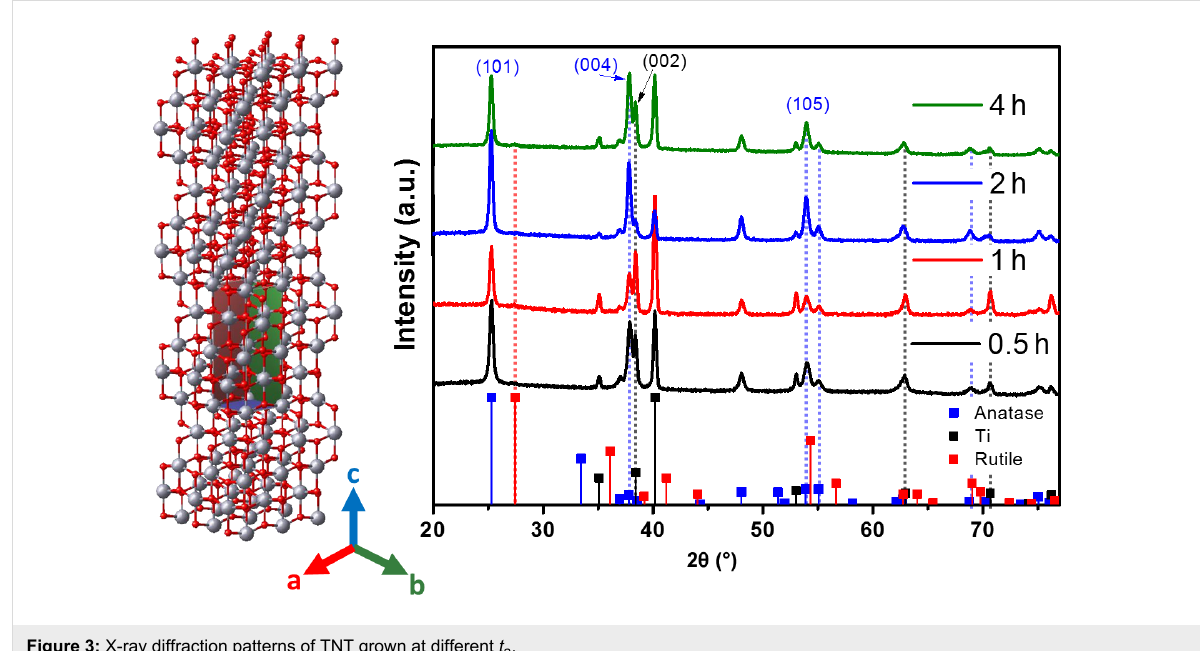
Figure 3: X-ray diffraction patterns of TNT grown at different t a .